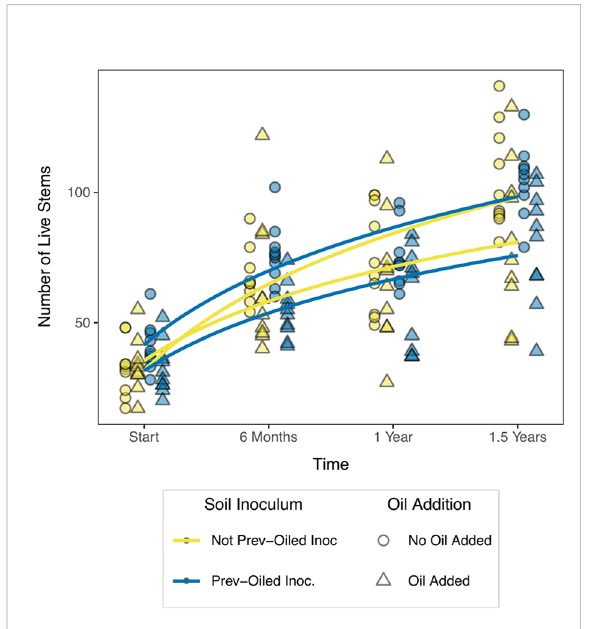
FIGURE 3 Live stem count over the course of the experiment. Triangles represent plants growing in mesocosms to which oil was added, circles are plants to which oil was not added. Soil inocula are represented by color. Curves are logarithmic curves (y ~ log(x)) fi tted with the “ glm ” method in the geom_smooth function from ggplot. By the end of the experiment, stem count had separated into two groups: those in which no oil was added (top two lines) and those in which oil was added (bottom two lines).